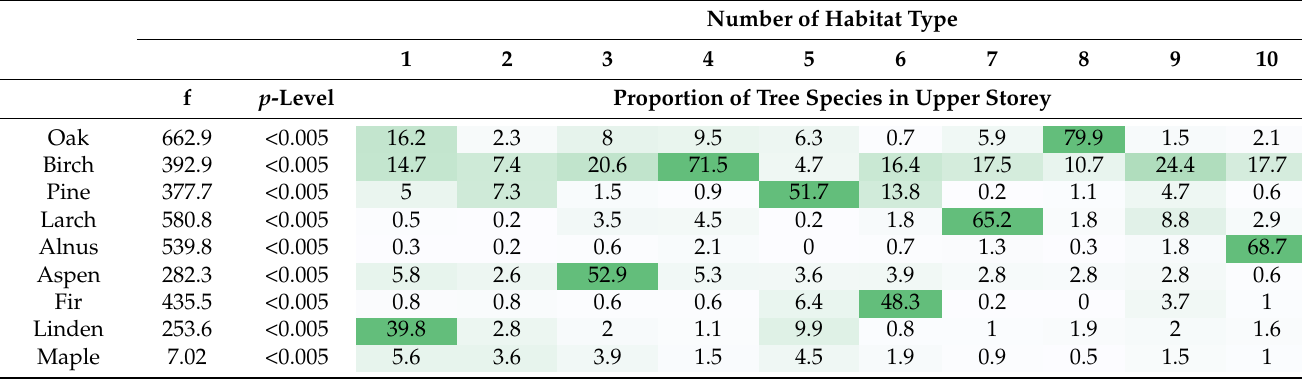
Table 3. Composition of tree species in upper storey. Table represents results of k-means classification based on tree species composition. Columns represent 10 types of forest habitats. Numbers in cells are percentages of certain tree species in each forest habitat type. F and p -value demonstrate representativeness of each forest habitat type